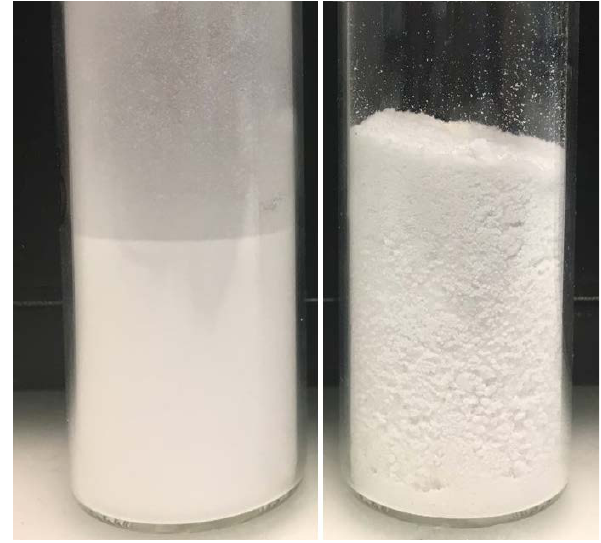
Figure 5. Sample i ( left ) and sample d ( right ) after spray